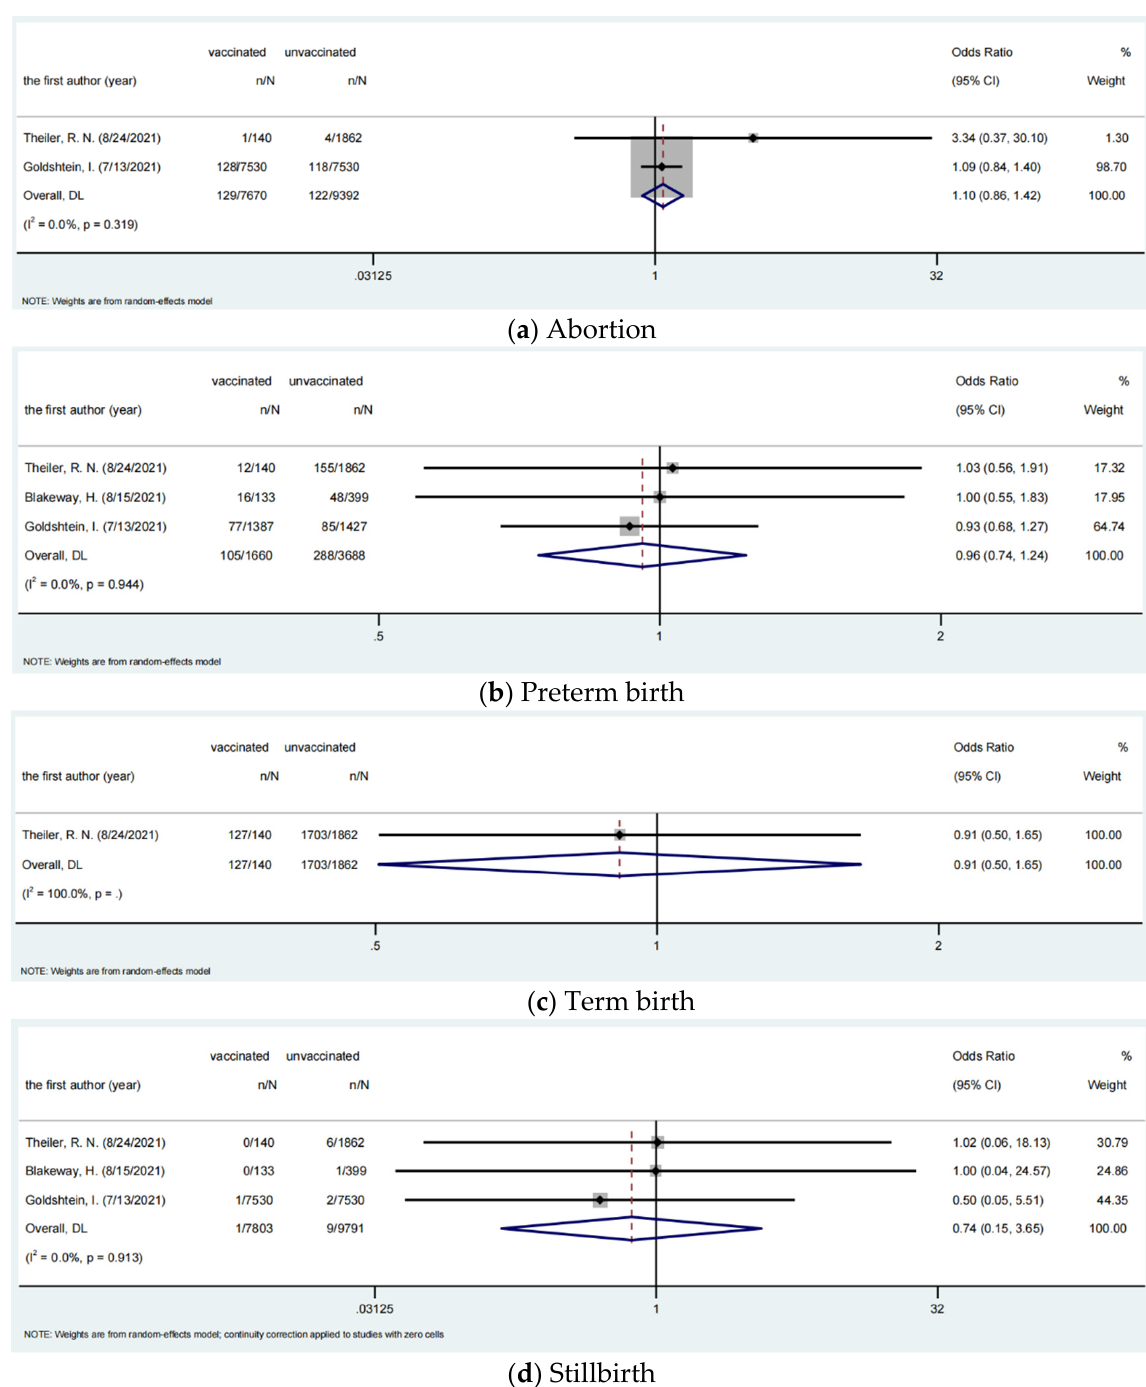
Figure 3. Fetal outcomes among pregnant women. We assessed the risk of adverse neonatal outcomes among vaccinated and unvaccinated pregnant women. A total of 2 studies involving 140 vaccinated pregnant women and 1862 unvaccinated pregnant women were assessed for the risk of low or very low birthweight (<2500 g) (OR = 1.35, 95% CI, 0.76–2.40), neonatal birth trauma (OR = 0.57, 95% CI, 0.03–9.77), hypoxic–ischemic encephalopathy (OR = 4.42, 95% CI, 0.18–108.91). A total of 3 studies involving 273 vaccinated pregnant women and 2261 unvaccinated pregnant women were assessed the risk of admission to the neonatal ICU (OR = 1.08, 95% CI, 0.48–2.42). We did not find any neonatal deaths among vaccinated and unvaccinated pregnant women. The results suggest that there is not an obvious connection between vaccination and adverse neonatal outcomes among vaccinated pregnant women. The analysis results